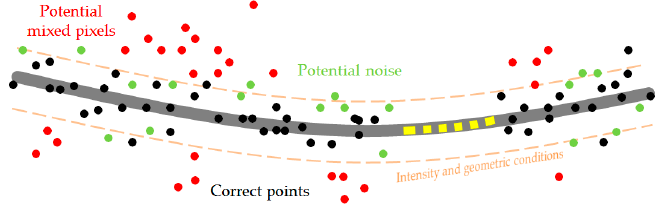
Figure 1. Schematic representation of erroneous points for linear objects.